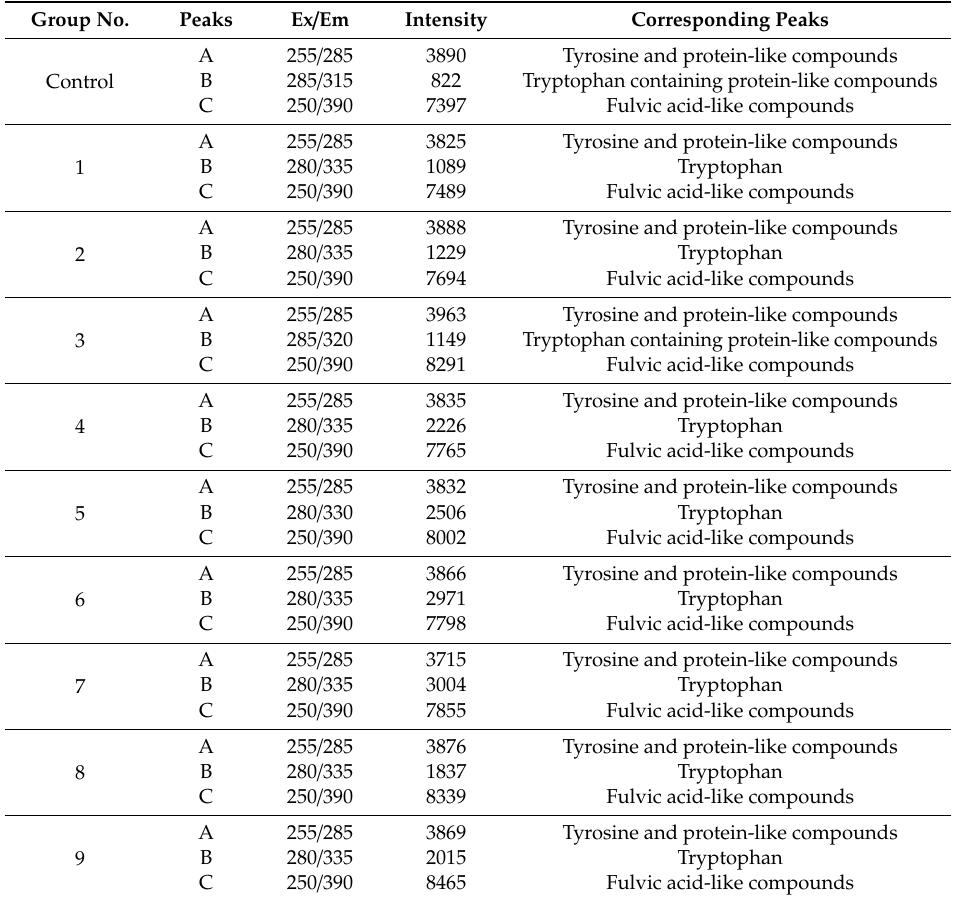
Table 4. Fluorescence spectral parameters of the EPS after 3 days of exposure to mixed allelochemicals. Group